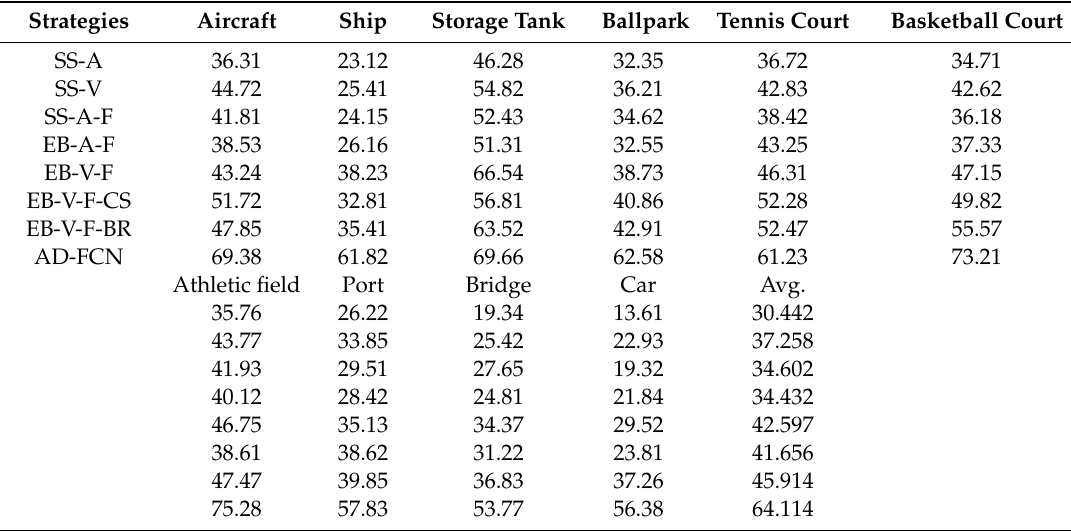
Table 3. Comparison among the proposed framework and other baselines detection strategies using the NWPU VHR-10 set in terms of